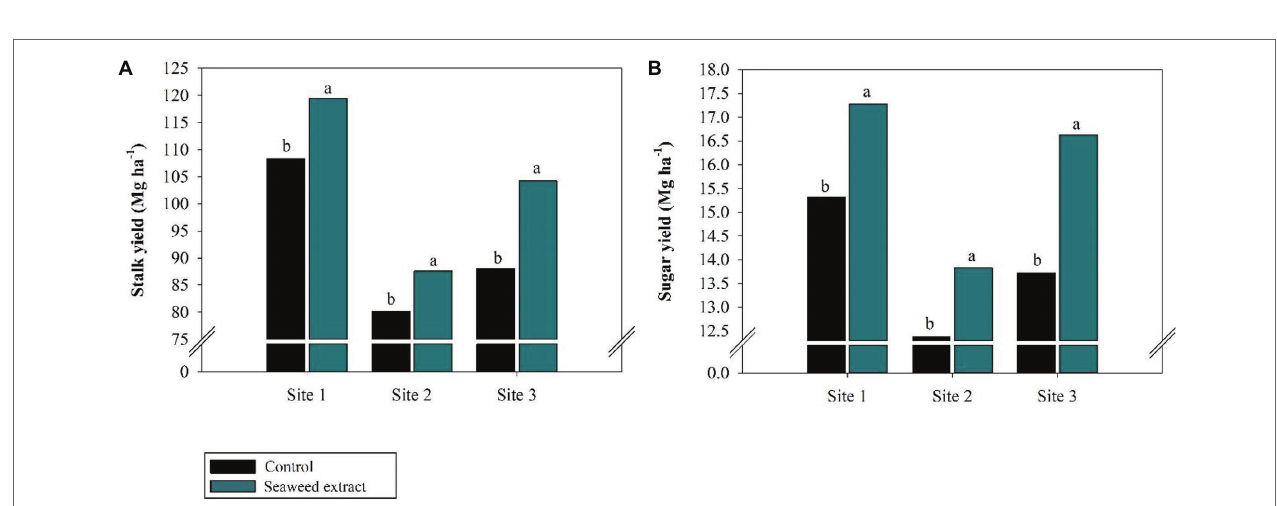
FIGURE 7 | Effects of seaweed extract (SWE) application on sugarcane biometric parameters at harvest: (A) stalk height (m), (B) diameter (mm). The treatments were as follows: Control, no SWE application; Seaweed extract: application of SWE biostimulant based on Ascophyllum nodosum in the beginning of the drought season (July at site 1 and June at sites 2 and 3). Averages followed by the same letters do not differ by the LSD test ( p < 0.10).